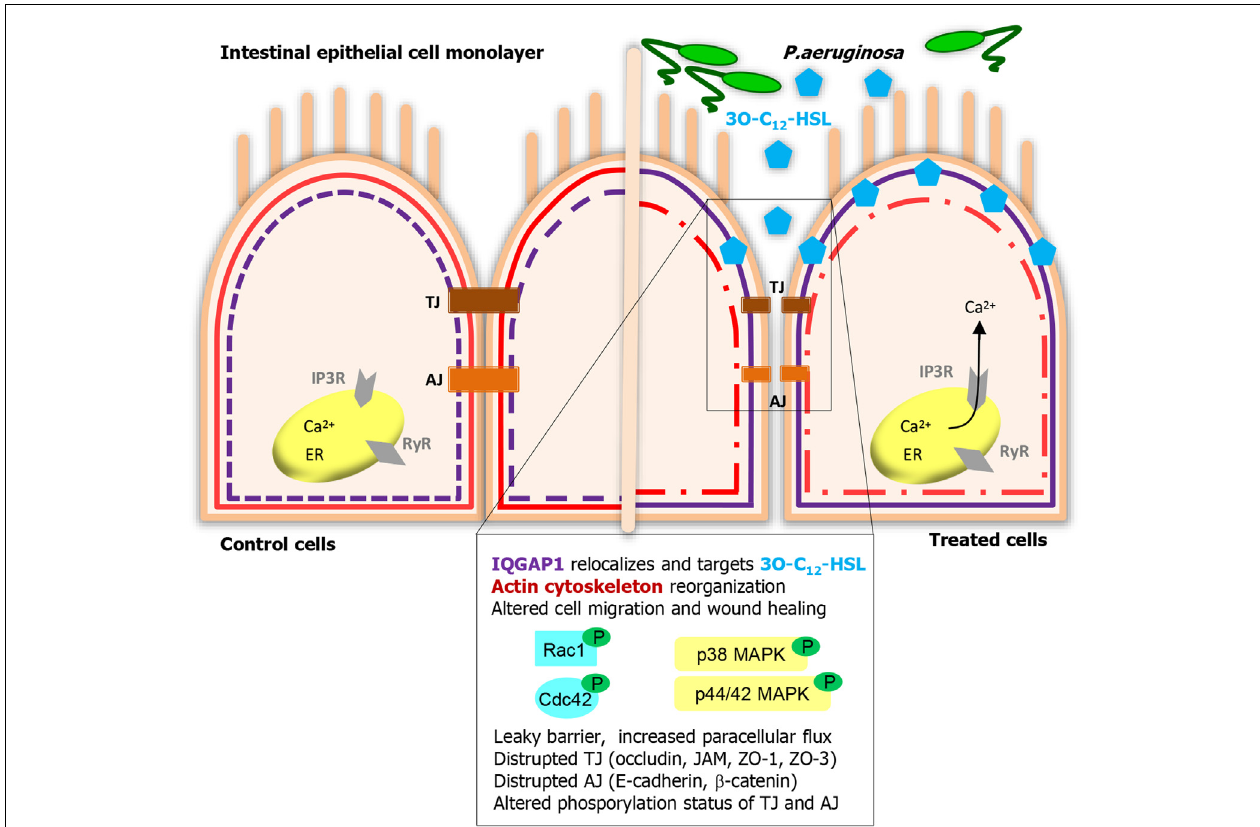
FIGURE 1 | Human intestinal epithelial cells listen to and act on Pseudomonas aeruginosa 3O-C 12 -HSL signaling. IQGAP1 is a novel membrane-associated target for 3O-C 12 -HSL that helps human epithelial cell recognize and response to bacterial QS signaling. Further, 3O-C 12 -HSL triggers multiple signaling pathways, those include